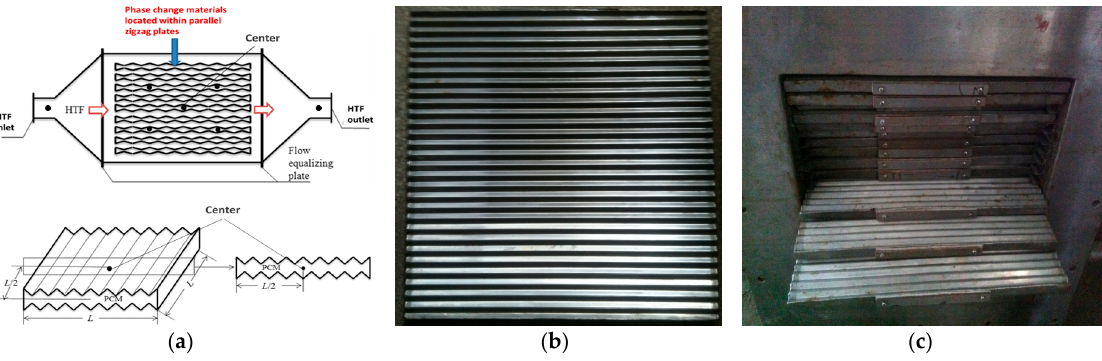
Figure 4. Zigzag plate heat exchanger unit. ( a ) Arrangement of the thermocouples; ( b ) surface of the zigzag plates; and ( c ) internal structure.